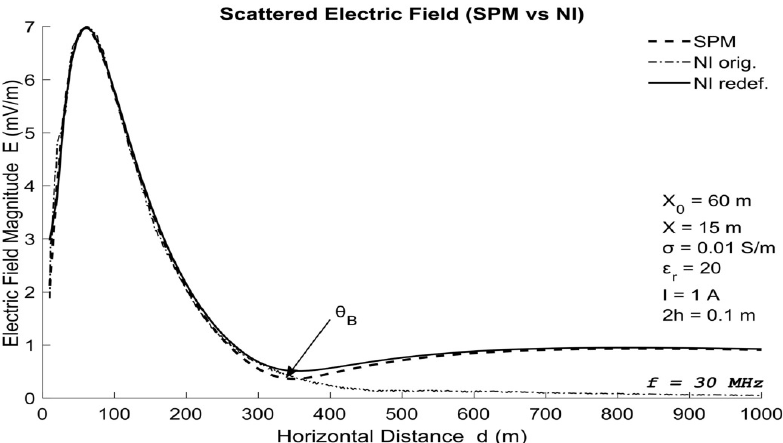
Figure 2. Comparison of numerical integration results for the received electric field using: (i) rede- fined integral expressions, (18) and (19)—solid, (ii) original integral expressions (1)–(3)—dash dotted. Scattered field values are